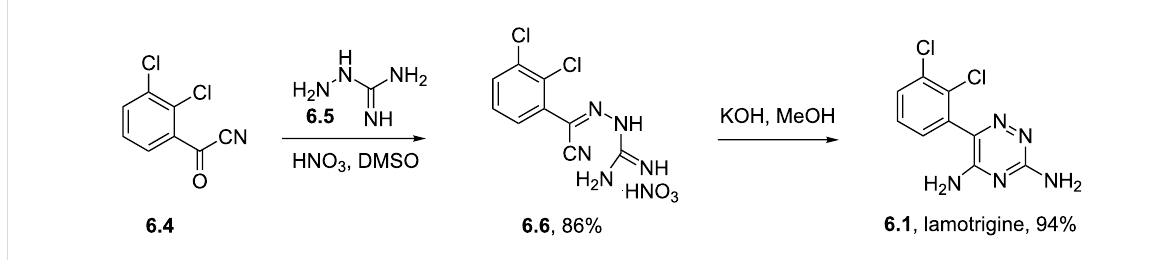
Scheme 50: Synthesis of lamotrigine.